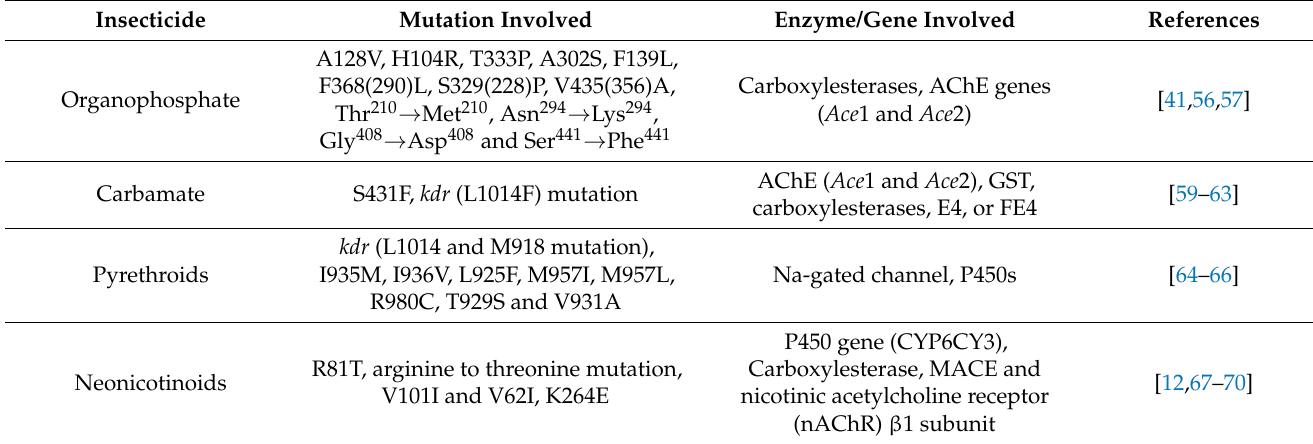
Table 2. Mutation and genes involved in the insecticide resistance mechanism in aphids. Insecticide Mutation Involved Enzyme/Gene